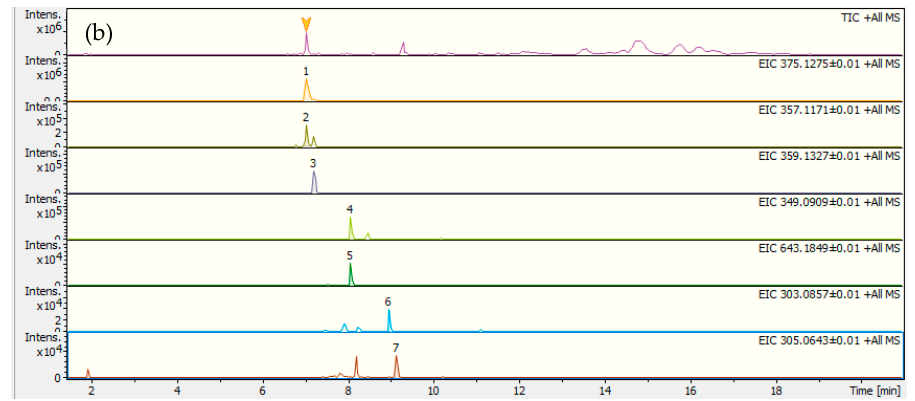
Figure 2. Total ionic chromatogram and ionic chromatograms extracted from ions identified in C.